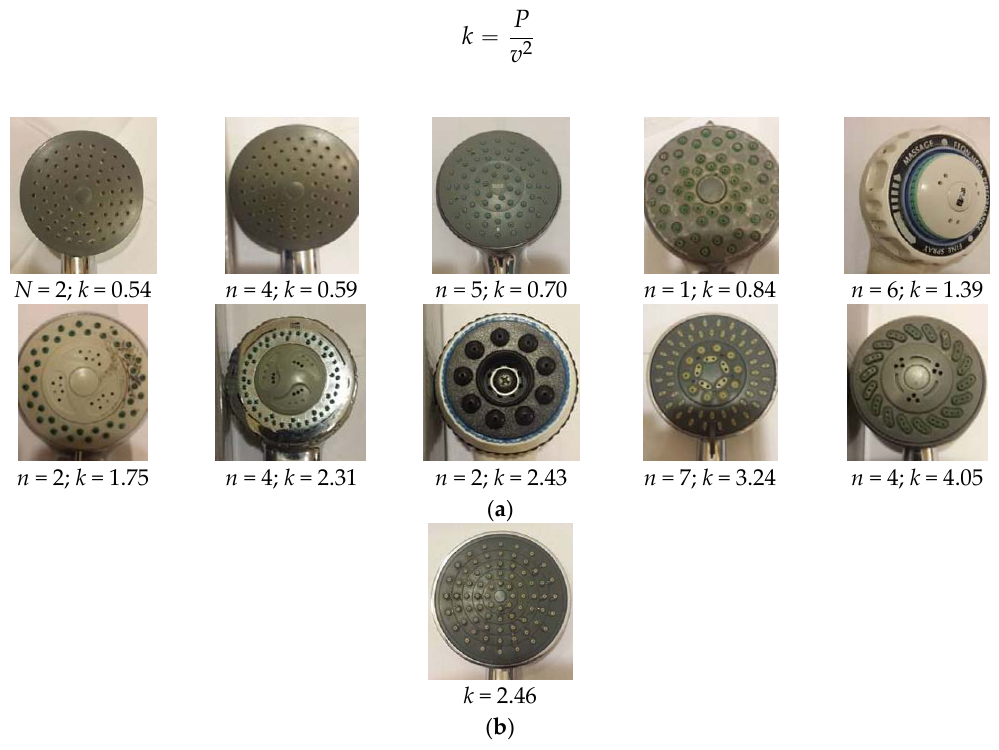
Figure 1. Showerheads under investigation: ( a ) showerheads used in 10 residential washrooms in Hong Kong; ( b ) a Water Efficiency Labelling Scheme (WELS) Grade 2 showerhead. Hong Kong; ( b ) a Water Efficiency Labelling Scheme (WELS) Grade 2